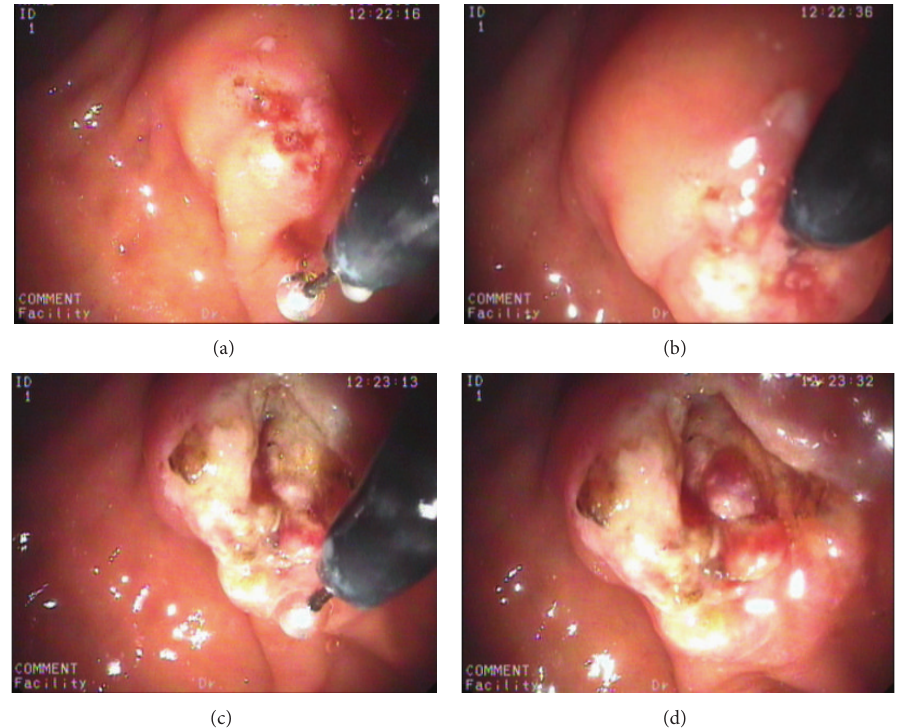
Figure 2: Duodenoscopic findings of precut sphincterotomy with the novel round insulated tip papillotome (r-ITP). (a) r-ITP is introduced in a patient with a prominent ampulla of Vater (AV). (b) r-ITP is placed in the orifice of AV. ((c) and (d)) Bile duct mucosa is exposed after precut